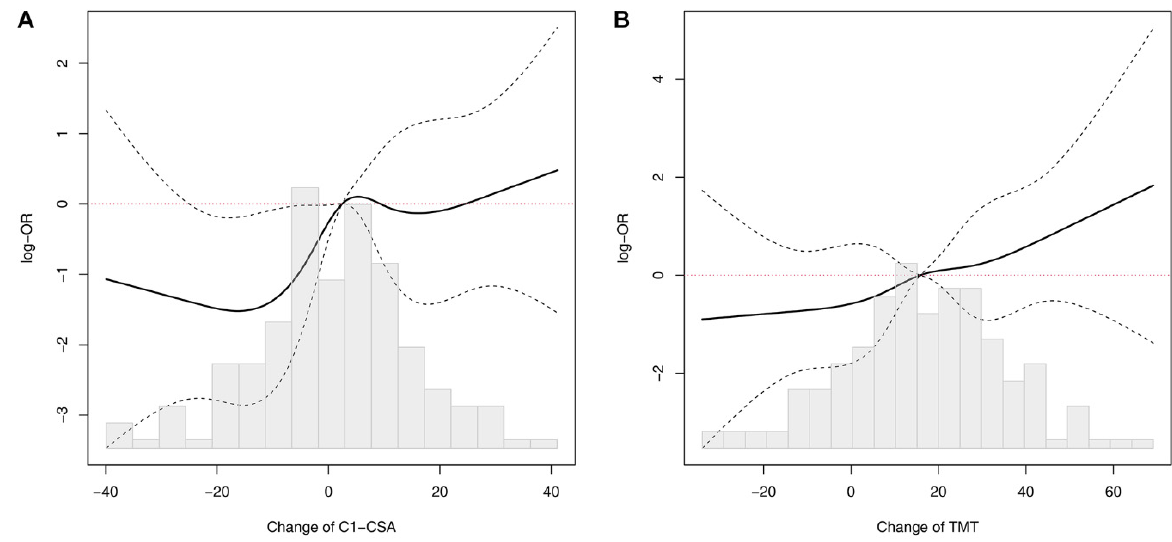
Figure 7. Association between changes in C1-CSA ( A ) or TMT ( B ) and poor neurologic outcome. OR, odds ratio; C1-CSA, the cross-sectional area at the level of the first cervical vertebra; TMT, temporalis muscle thickness; Change of C1-CSA, 100 × (initial C1-CSA minus follow-up C1-CSA)/initial C1-CSA; and change of TMT, 100 × (initial TMT minus follow-up TMT)/initial TMT.